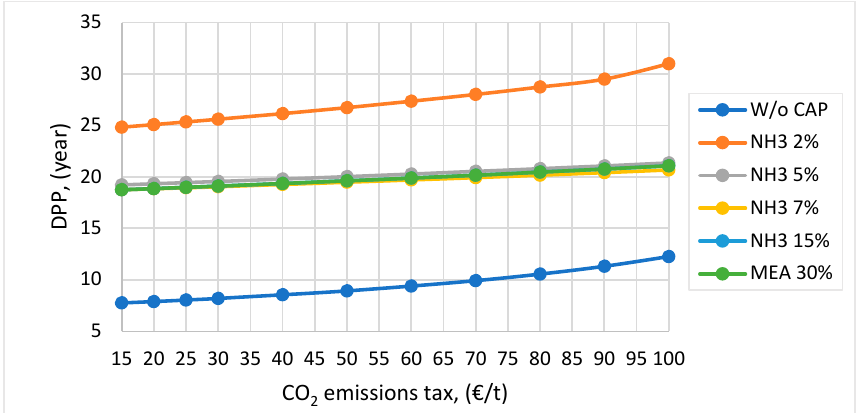
Figure 6. IRR with and without the CO 2 capture process according to the CO 2 emissions tax.